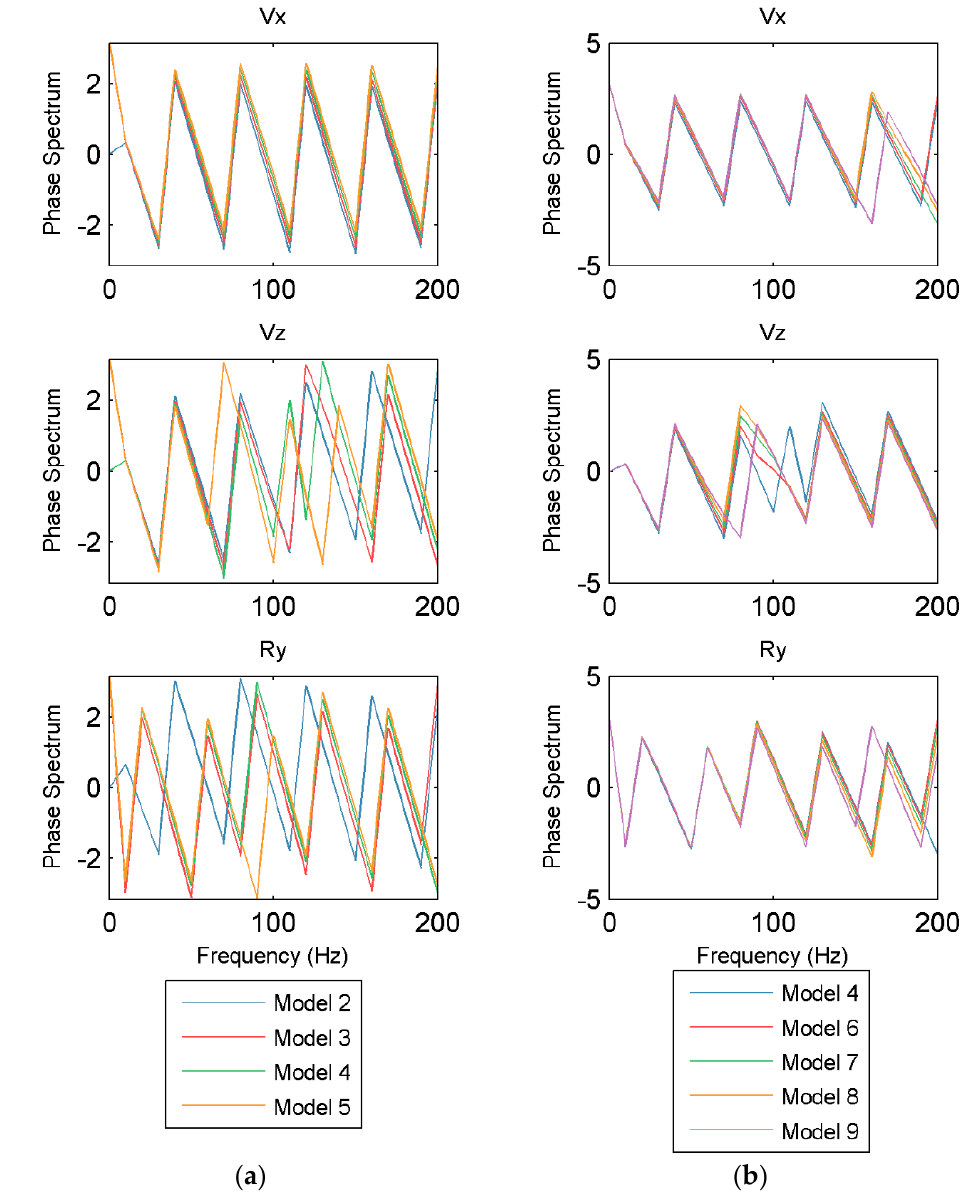
Figure 11. Influence of anisotropy parameters on phase spectra of the 90th trace generated from the expansion source: ( a ) when ε varies; ( b ) when δ varies.